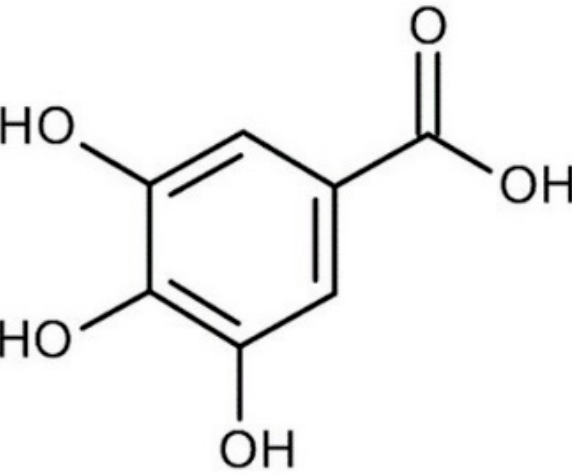
Figure 4. Chemical structure of gallic acid.